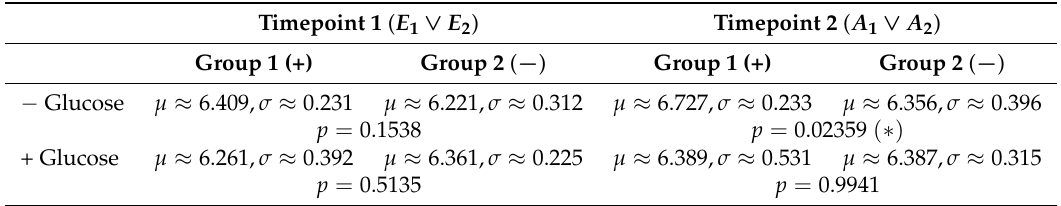
Table 2. Mean and standard deviation of miR-532-5p expression in samples from the two glucose recommendation groups split by the four study timepoints ( E 1 , A 1 , E 2 , A 2 ). Samples from a non-treatment interval are marked with − Glucose. Conversely, + Glucose notes scores generated from treatment samples. p -Values were obtained with Welch two sample t-tests using samples from each recommendation group with the same pre- (Timepoint 1) or post-training (Timepoint 2) label in either of the two treatment intervals ( − Glucose, +